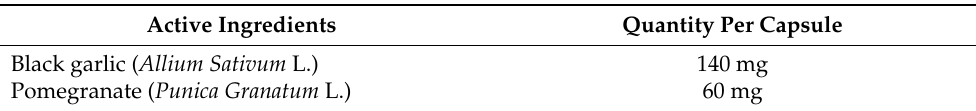
Table 1. Quantitative composition of the dietary supplement—namely SelectSIEVE ® SlowBeat—used in the clinical study. Active Ingredients Quantity Per Capsule Black garlic ( Allium Sativum L.) 140 mg Pomegranate ( Punica Granatum L.) 60